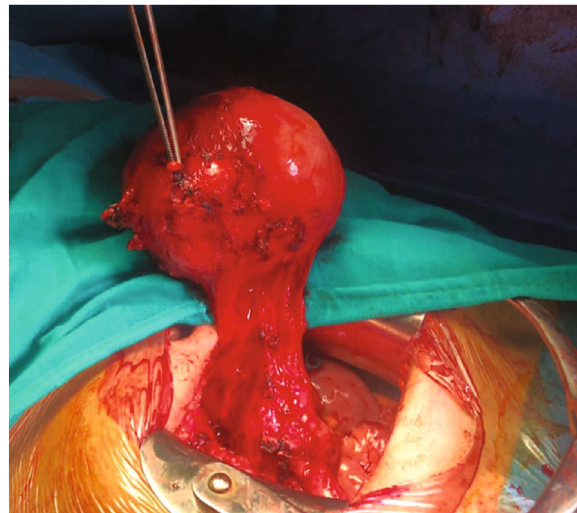
Figure 3: Intraoperative view of an abdominopelvic mass with satellite nodes.